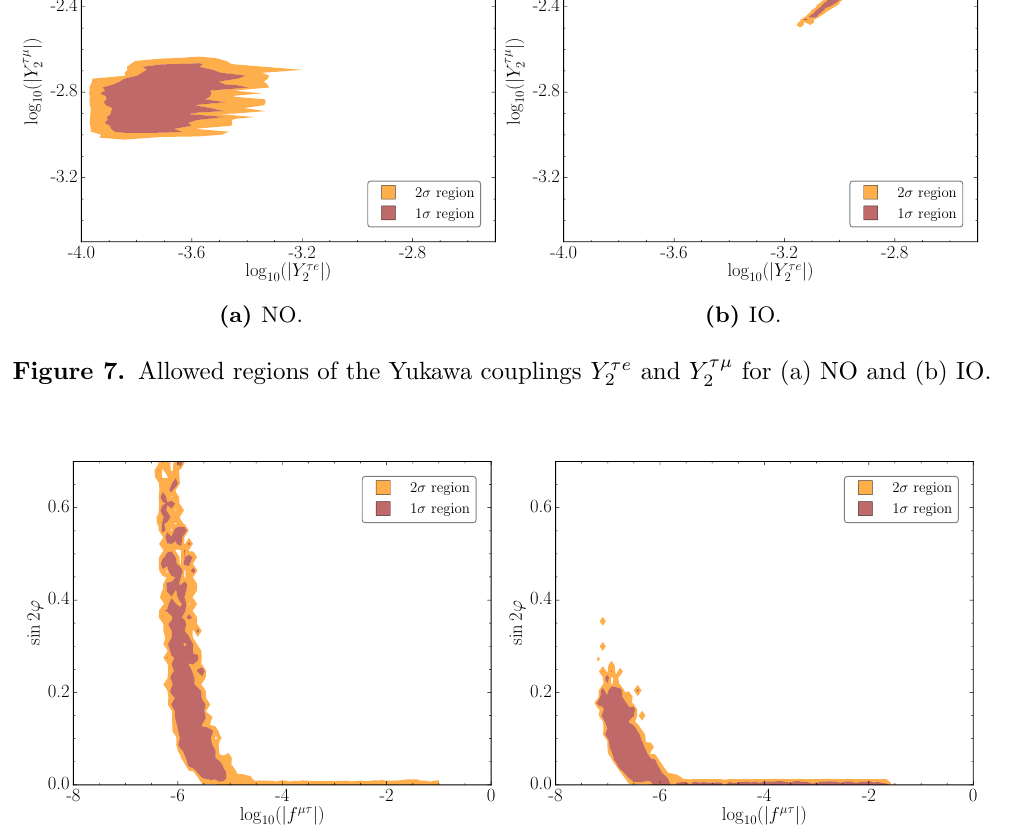
Figure 8. Allowed regions of the Yukawa coupling f (cid:22)(cid:28) and the mixing angle sin 2 ’ for (a) NO and (b)